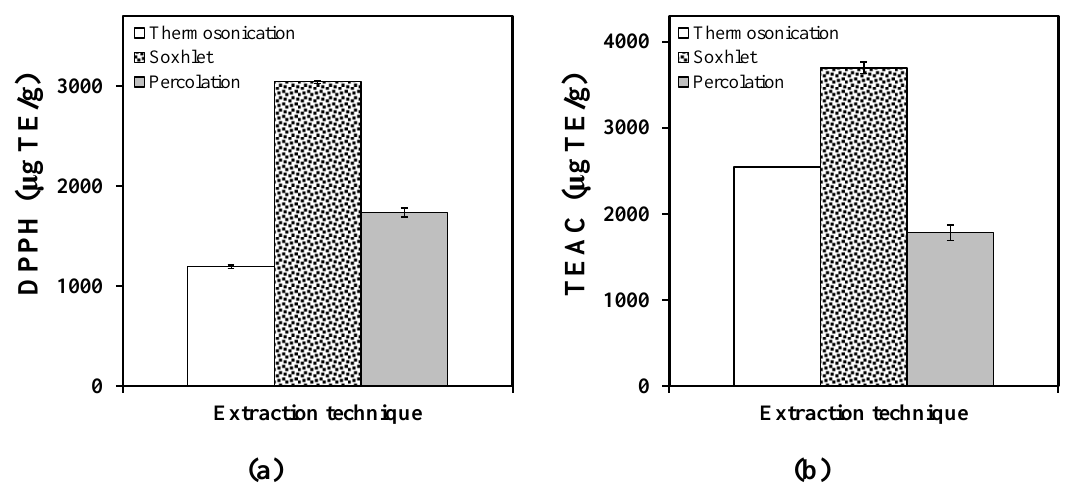
Figure 7. Antioxidant capacity of extracts acquired by each extraction method using ( a ) DPPH and ( b ) ABTS as chro- mophore radicals.